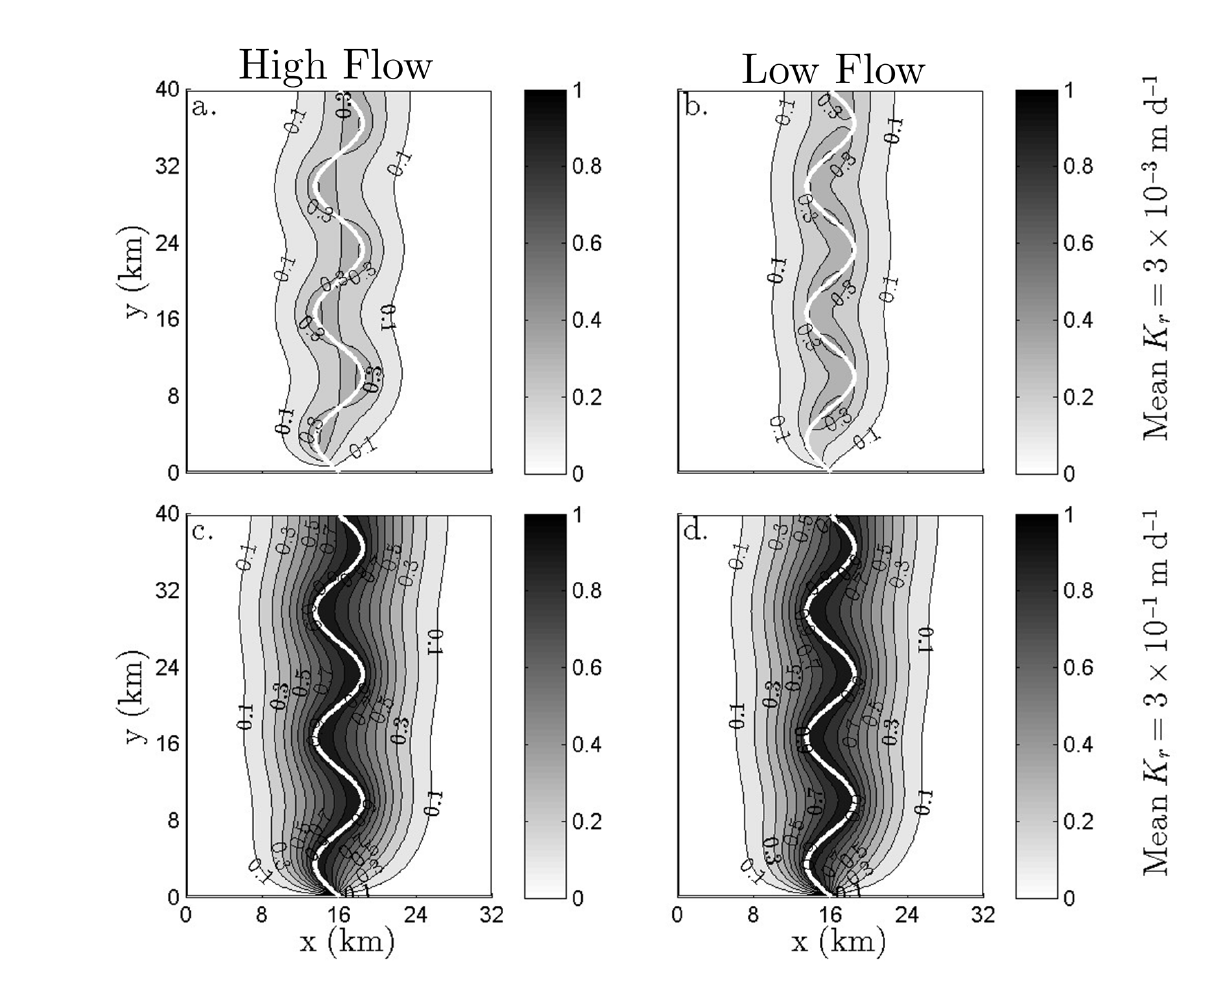
/Q Figure 6. Normalized stream depletion ( ∆ Q ) at each potential well location in an r p aquifer with K = 5 m d − 1 for four heterogeneous scenarios after 20 years of pumping. = 3 × 10 − 3 m d − 1 (within sensitive range); ( b ) Low ( a ) High flow regime with mean K r = 3 × 10 − 3 m d − 1 (within sensitive range); ( c ) High flow regime flow regime with mean K r = 3 × 10 − 1 m d − 1 (above sensitive range); ( d ) Low flow regime with mean with mean K r K = 3 × 10 − 1 m d − 1 (above sensitive r